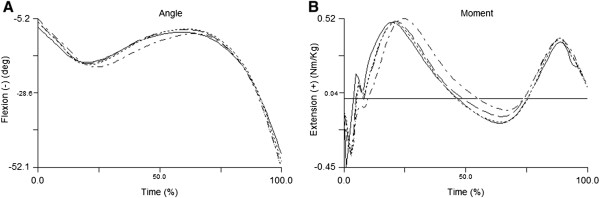
Ensemble curves of knee sagittal plane angle (A) and moment (B) of all four footwear conditions, where the solid line is for barefoot, dash line for sandals, dotted line for flip-flops, and dash-dotted line for shoes.